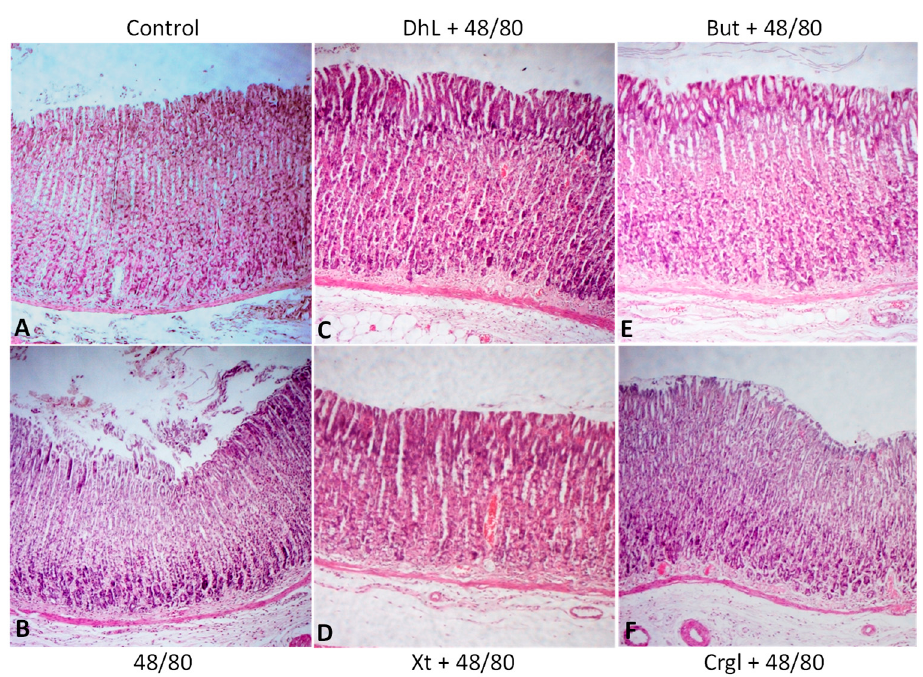
Figure 4. Paraffin sections (6 µ m) of gastric walls stained by hematoxylin-eosin. Gastric mucosa can be seen. ( A ) Control; ( B ) compound 48/80; ( C ) DhL + compound 48/80; ( D ) Xt + compound 48/80; ( E ) But + compound 48/80; ( F ) Crgl + compound 48/80. × 100.